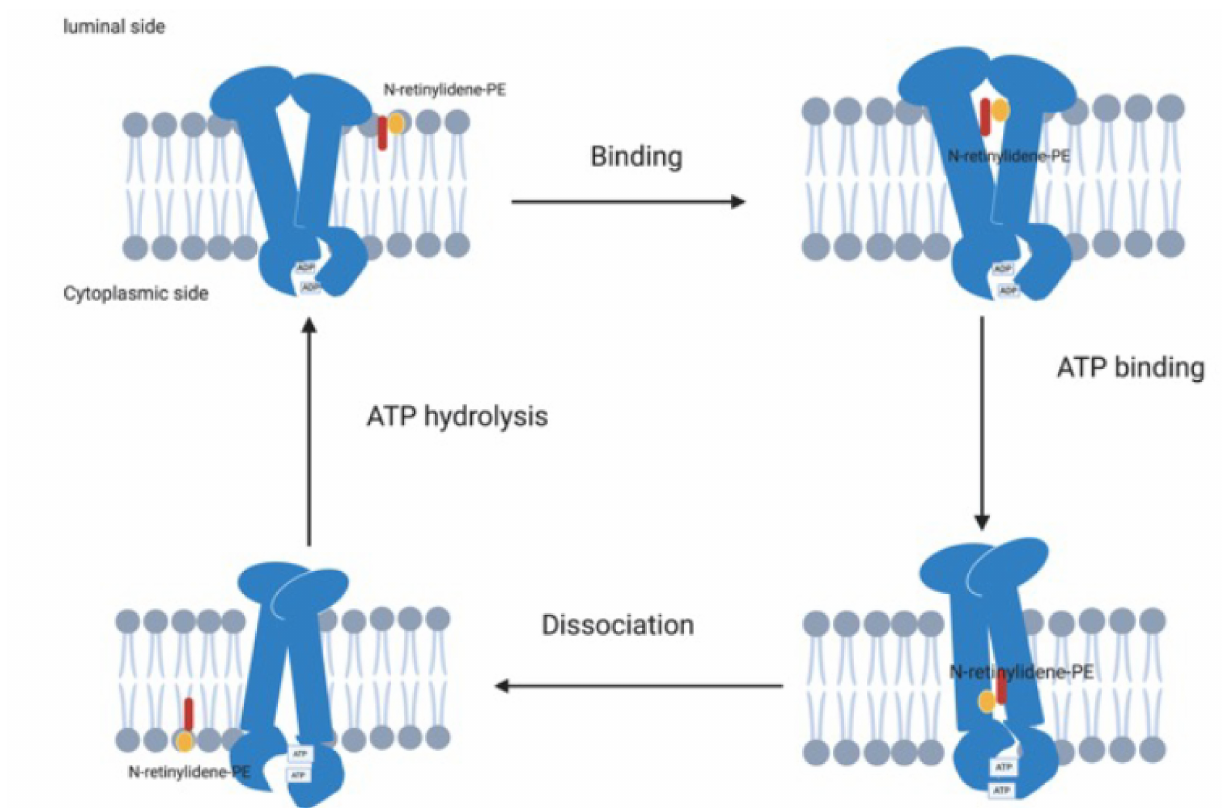
Figure 4. Schematic diagram of the ABCA4 protein actively transporting NrPE from the luminal side of the photoreceptor disc membrane to the cytoplasmic side. The ADP is initially bound to the NBD and the ABCA4 binds the NrPE on the luminal side of the photoreceptor disc membrane; this is followed by binding of ATP to the NBDs, leading to a conformational change that creates a low affinity binding site on the cytoplasmic side, resulting in dissociation of the NrPE from the ABCA4 protein and followed by hydrolysis of the ATP, returning the ABCA4 to its primary conformation. Adapted from Molday et al. [37]. Created with BioRender.com (accessed on 1 June 2021). Abbreviations: NBD: nuclear binding domain; NrPE: N-retinylidene